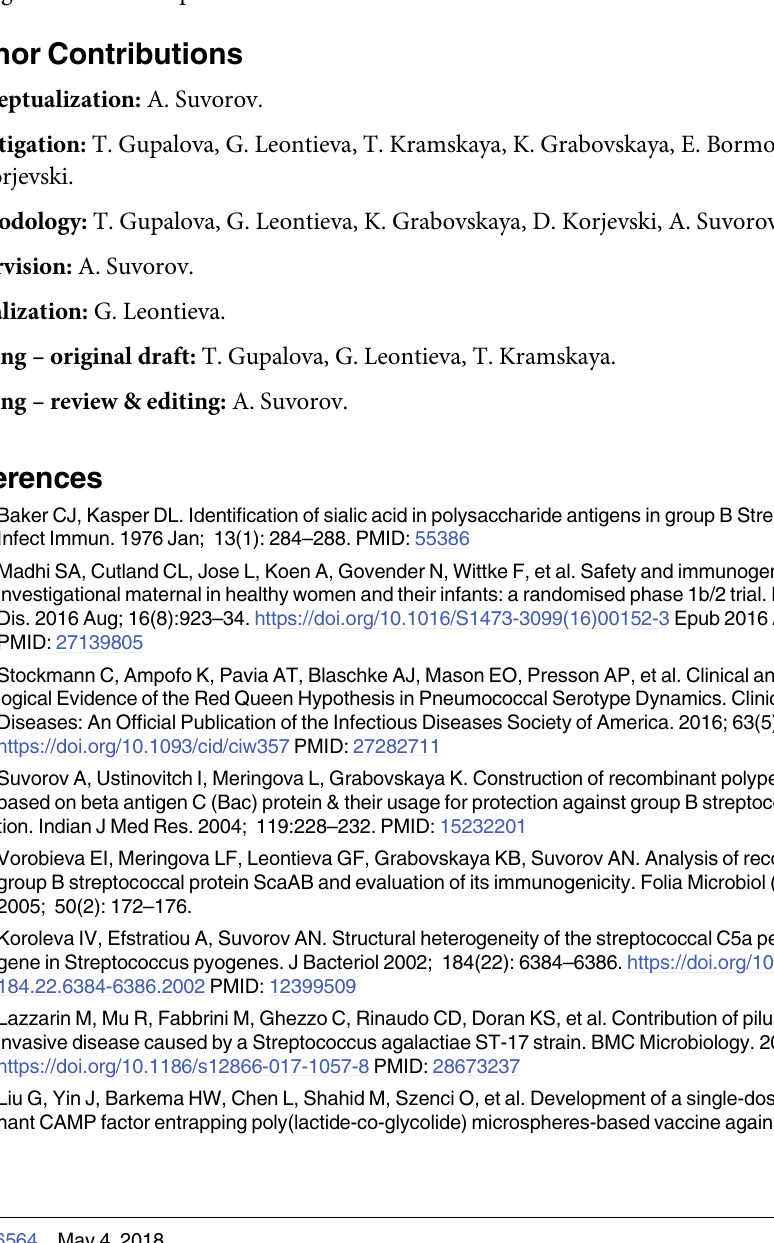
S1 Protocol. Conversion of antibody dilutions and OD values (based on ELISA readings) to antibody